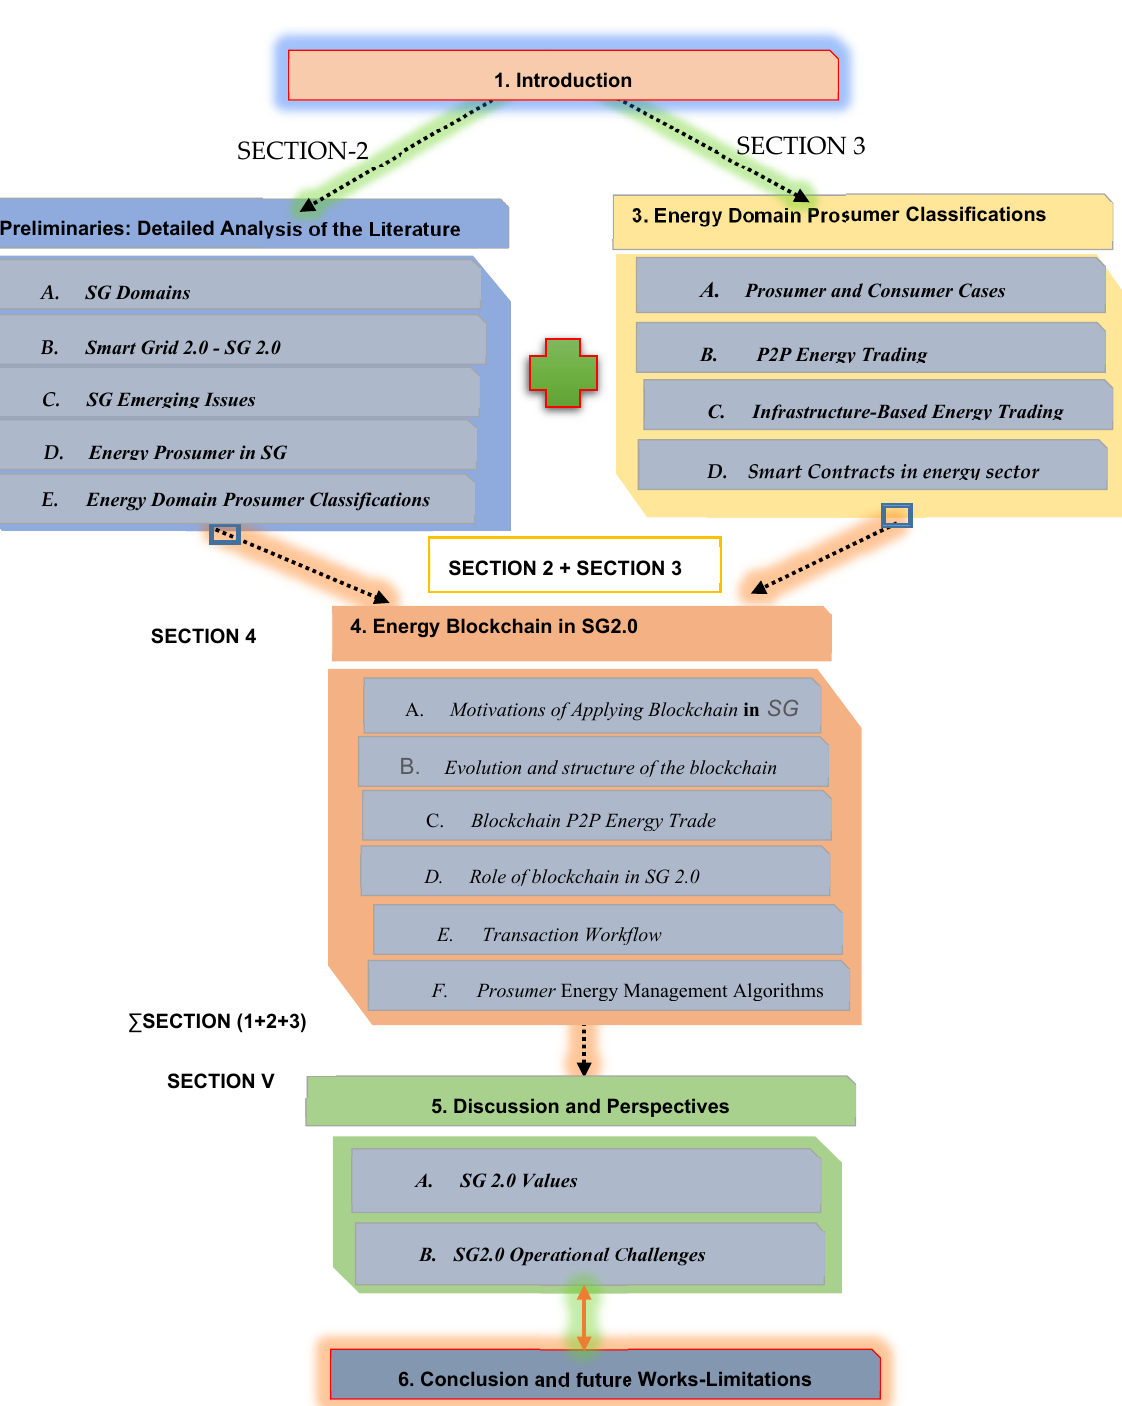
Figure 1. Description of survey paper Figure1. Description of survey paper sections 194